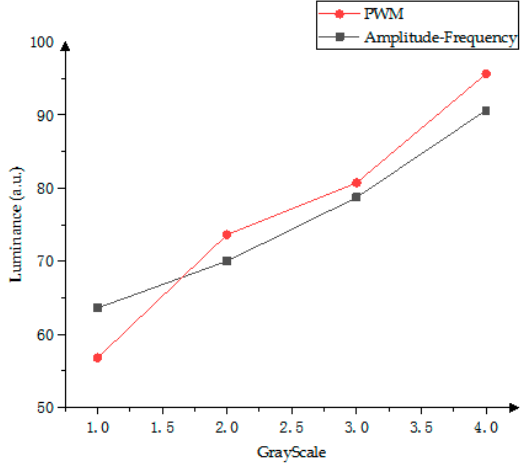
Figure 14. Luminance linear comparison of gray scale between the PWM scheme and the amplitude– frequency mixed modulation.